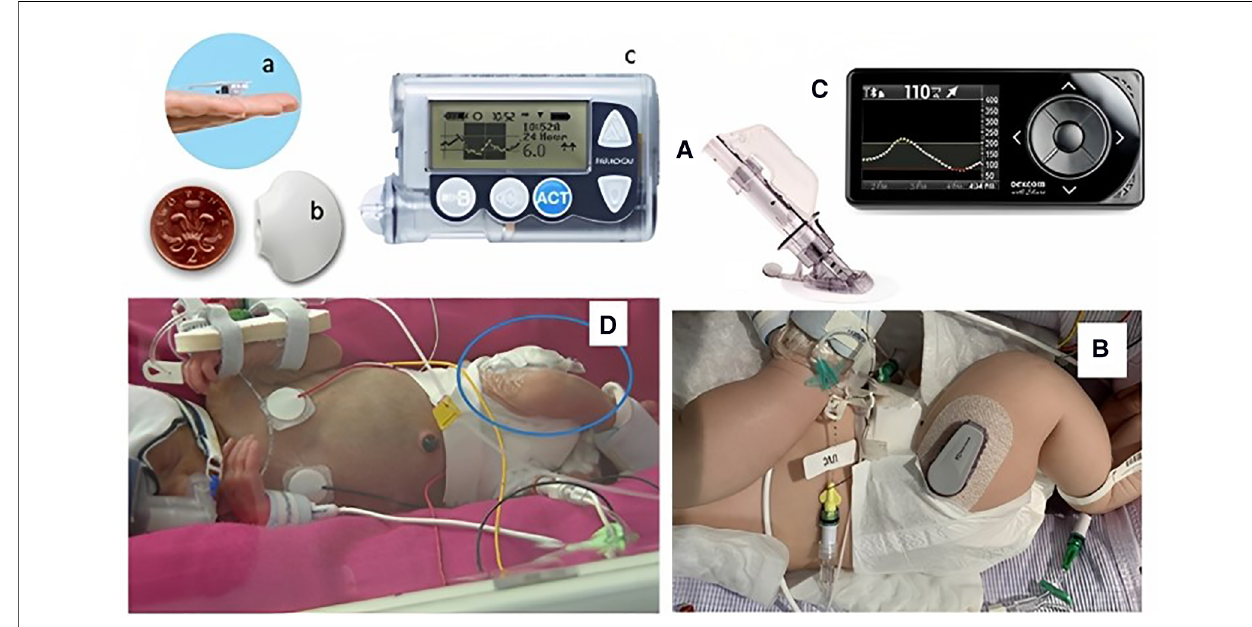
FIGURE 1 Continuous glucose monitoring systems in situ in two neonates. Neonates with continuous glucose monitoring in situ . Left panel showing Medtronic Guardian in a preterm baby: ( a ) sensor, ( b ) transmitter, ( c ) monitor, ( D ) baby with sensor in thigh. Right panel showing a Dexcom G4 with: ( A ) needle inserter, ( B ) transmitter on a baby ’ s thigh, and ( C ) monitor. Figure reproduced from Myat Win, Rowan Beckett, Lynn Thomson, Ajay Thankamony, Kathryn Beardsall, continuous glucose monitoring in the management of neonates with persistent hypoglycemia and congenital hyperinsulinism,